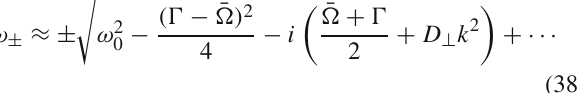
Fig. 4 Dependence of ¯ (cid:18)/ T on β for T /μ = 0 . 1 and α/μ =